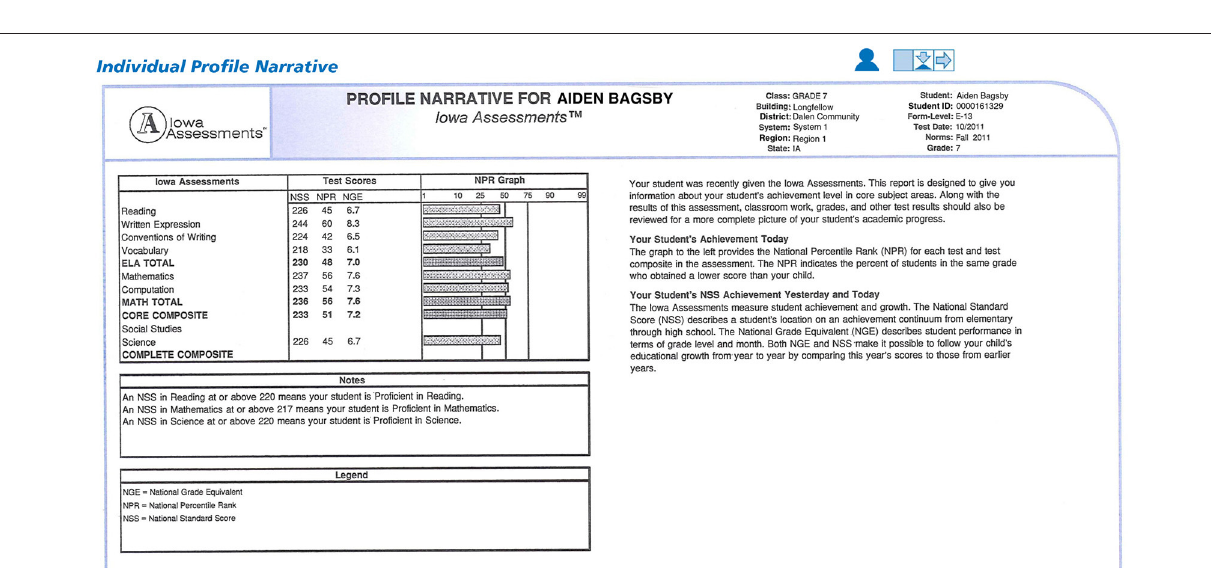
FIGURE 4 | Presentation of a sample student’s scores on the Iowa Individual Profile Narrative. From Iowa Assessments TM . Copyright © by the University of Iowa. Used by permission of the publisher, Houghton Mifflin Harcourt Publishing Company. All rights